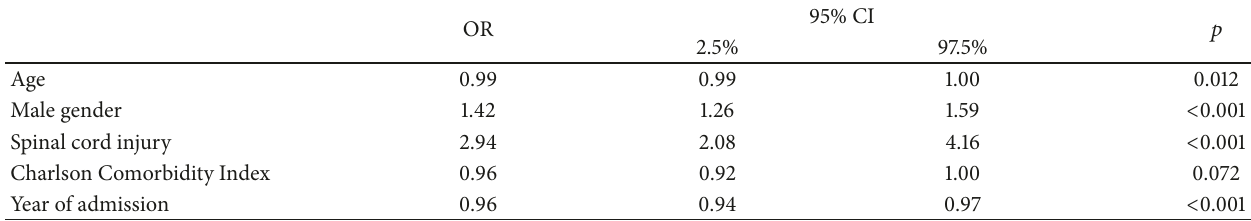
Table 3: The assignment to surgical treatment was dependent on younger age, male gender, spinal cord injury, and earlier year of admission. Odds ratios are presented with 95% CI and 𝑝 value.